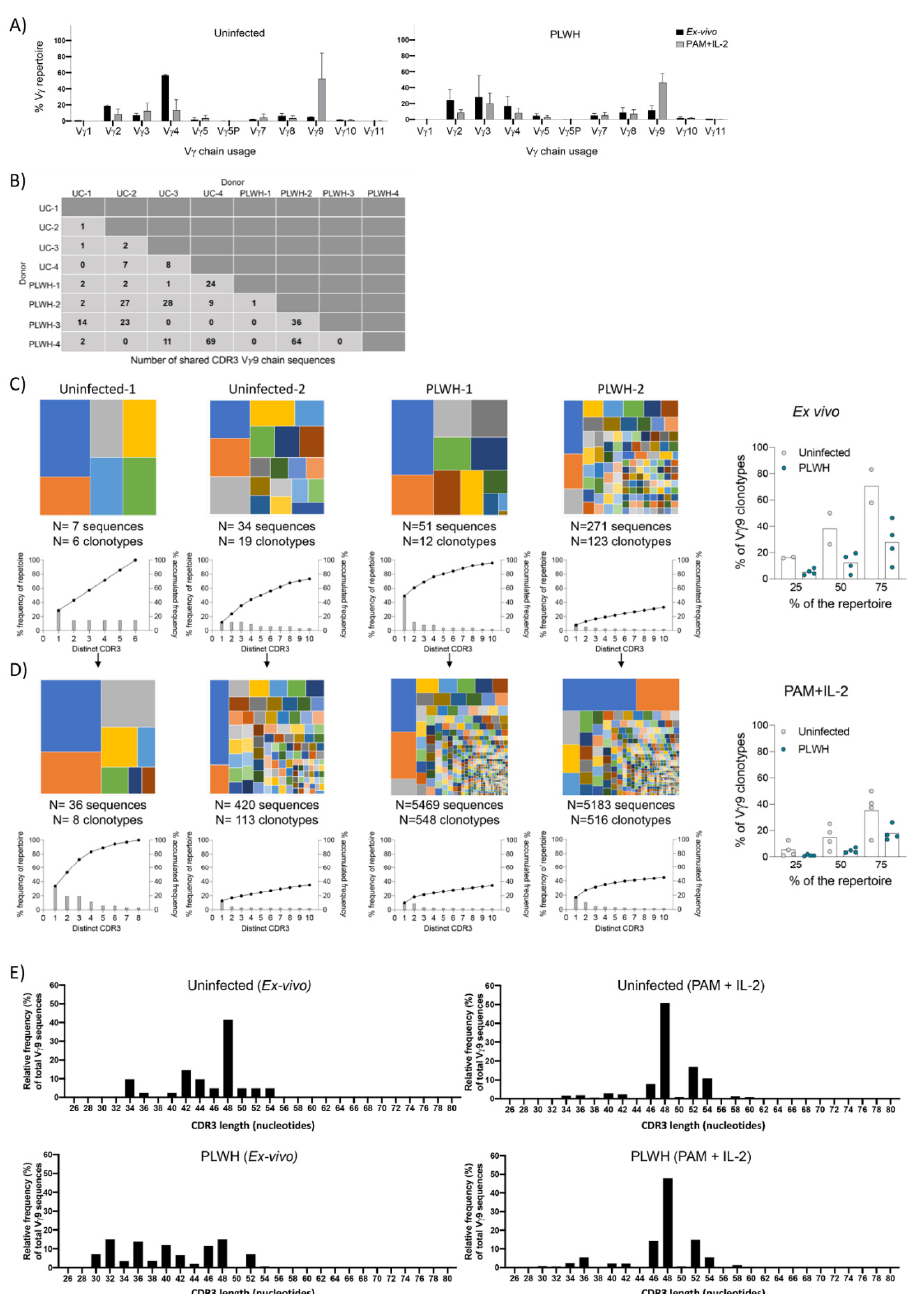
Figure 6. TCR γ chain analysis in uninfected donors compared to PLWH. ( A ) TCR γ chain usage ex vivo (black) and after expansion (grey). ( B ) Publicity of V γ 9 sequences, showing the number of shared CDR3 V γ 9 sequences shared between the 8 individuals of the cohort. ( C ) (Left) Tree maps showing V γ 9 CDR3 clonotypes relative to repertoire size for uninfected and PLWH samples ex vivo with graphs below showing percentage clone abundance (grey bars) (left y -axis) for the top 10 most prevalent clonotypes. Accumulated frequency of the top 10 clonotypes is shown on the same graph (black line above bars). (Right) Graphs show the percentage of V γ 9 CDR3 clonotypes that make up various proportions of the total repertoire i.e., D25 (25%), D50 (50%), and D75 (75%). ( D ) Tree maps of uninfected and PLWH samples after 7-day treatment with PAM + IL-2. Representative PLWH samples are shown based on lowest and highest number of clonotypes. ( E ) V γ 9 CDR3 length from ex vivo and expanded samples from uninfected donors (UC) and PLWH. Ex vivo: UC ( n = 2), PLWH ( n = 4). Expanded: UC ( n = 4), PLWH ( n =